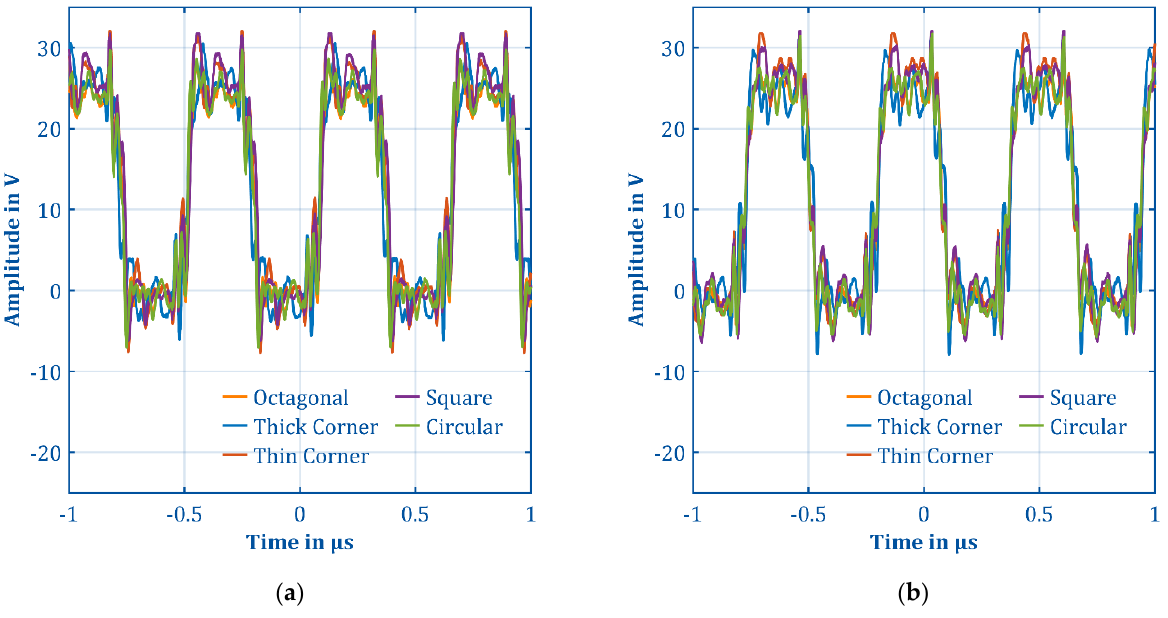
Figure A8. ( a , b ) Show the voltage signals at the secondary winding of the transformers at 1.75 MHz.